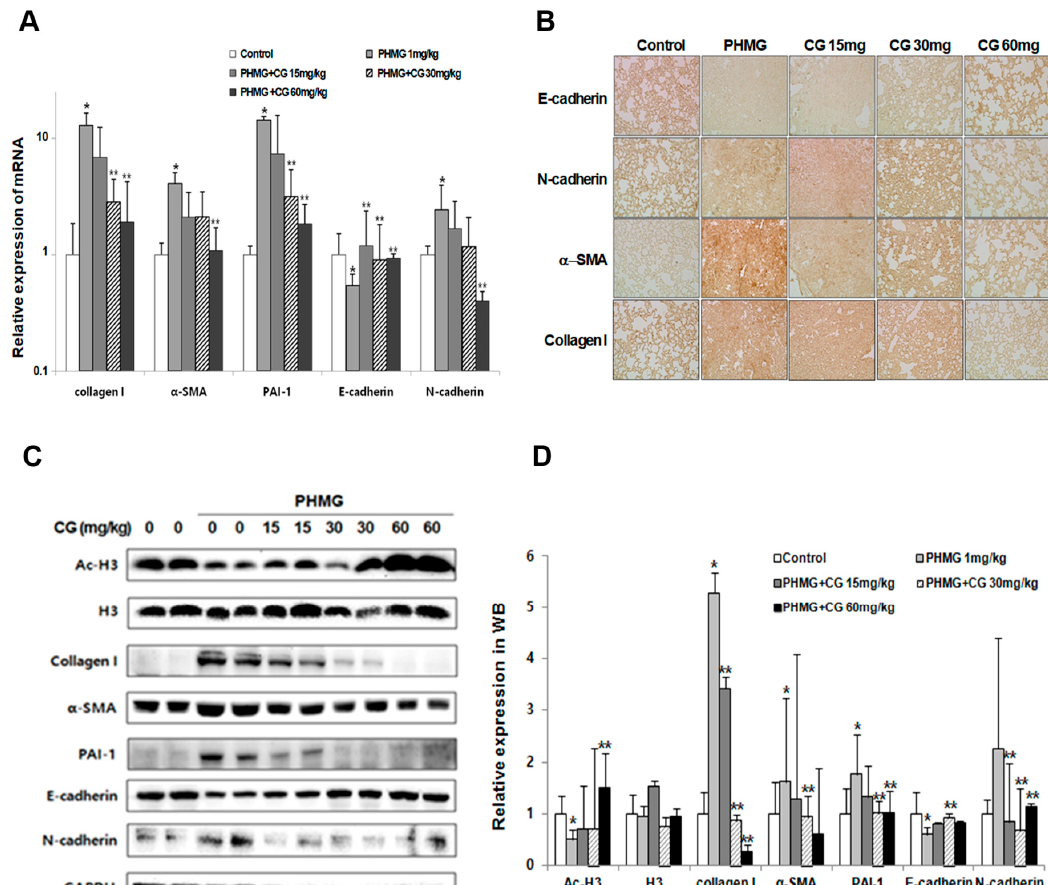
Figure 6. Effects of CG-745 on PHMG-induced epithelial-mesenchymal transition and fibrosis of mice. ( A ) The mRNA levels of fibrotic marker (collagen I, α -SMA, PAI-1) and EMT marker (E-